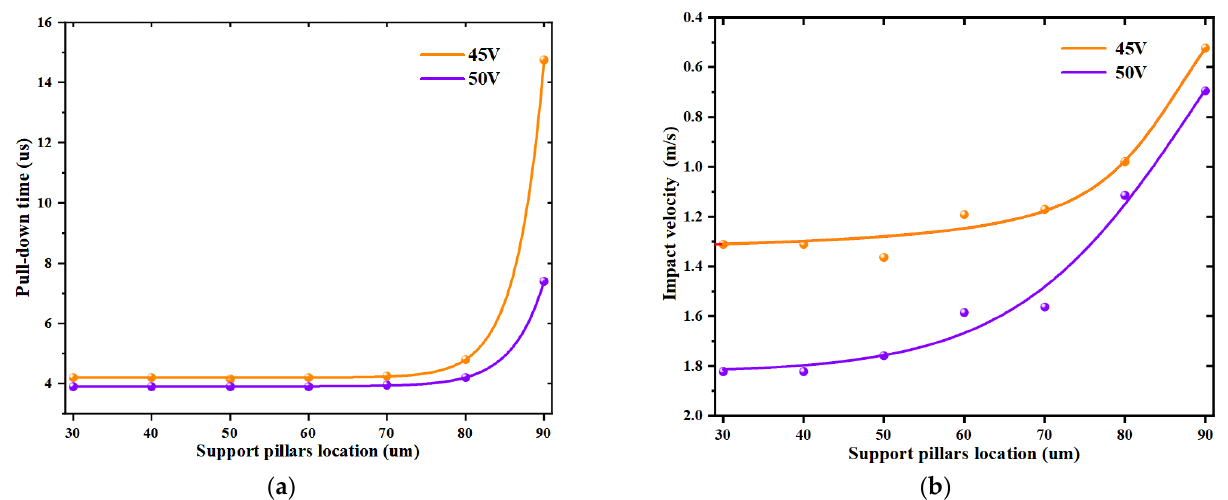
Figure 10. ( a ) Pull-in time at different positions of the support pillar, ( b ) Impact velocity at different positions of the support pillar.